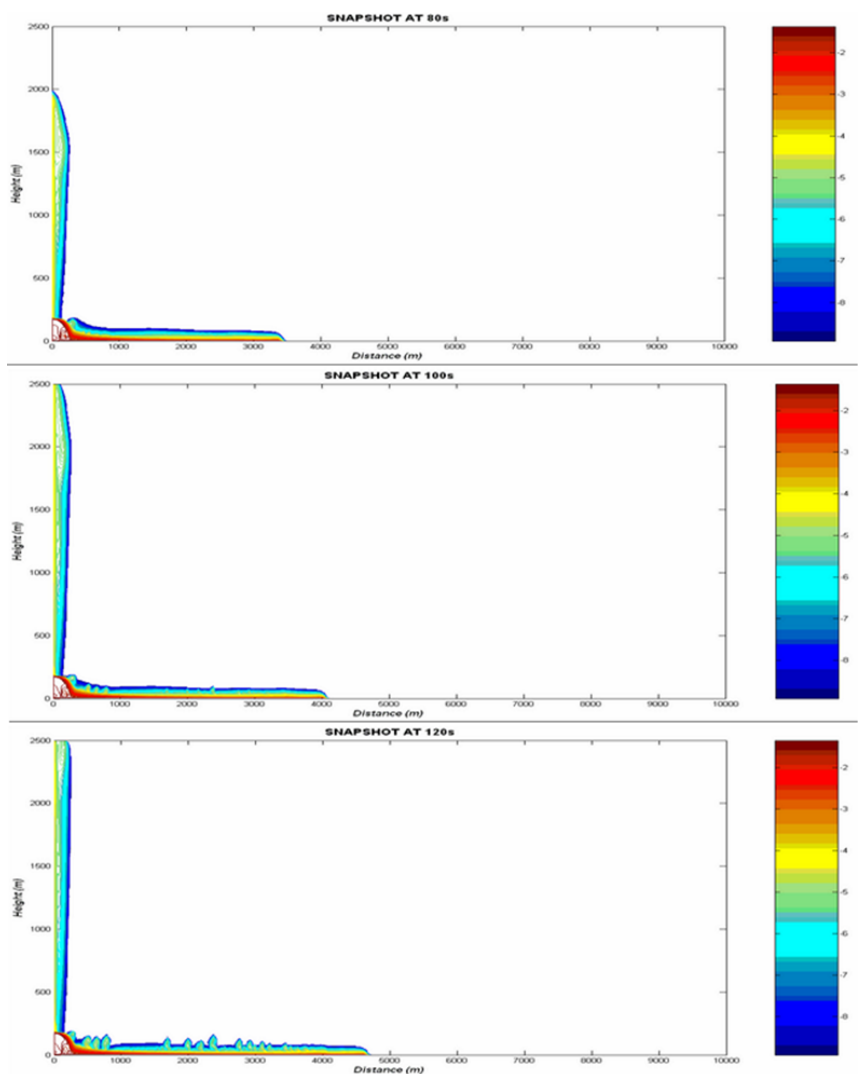
Fig. 2b. Snapshots of the solid particle concentration (logarithmic scale) as a function of distance and height at 80s, 100s, and